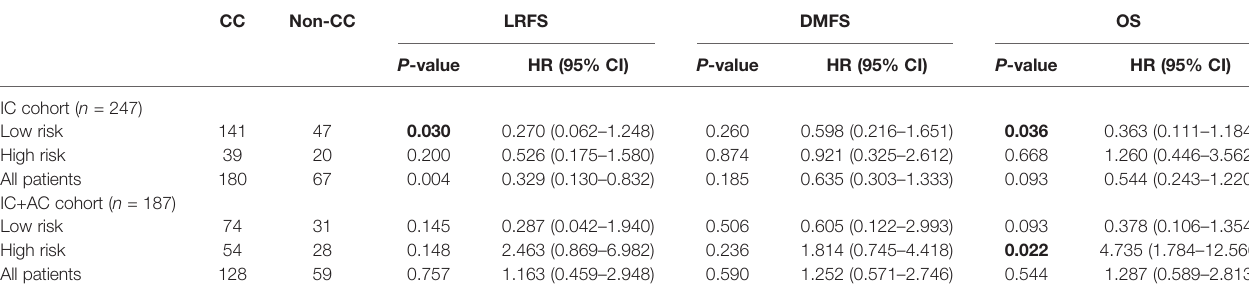
TABLE 3 | Effects of concurrent chemotherapy on LRFS, DMFS, and OS in different subgroups according to the risk score of the nomogram.